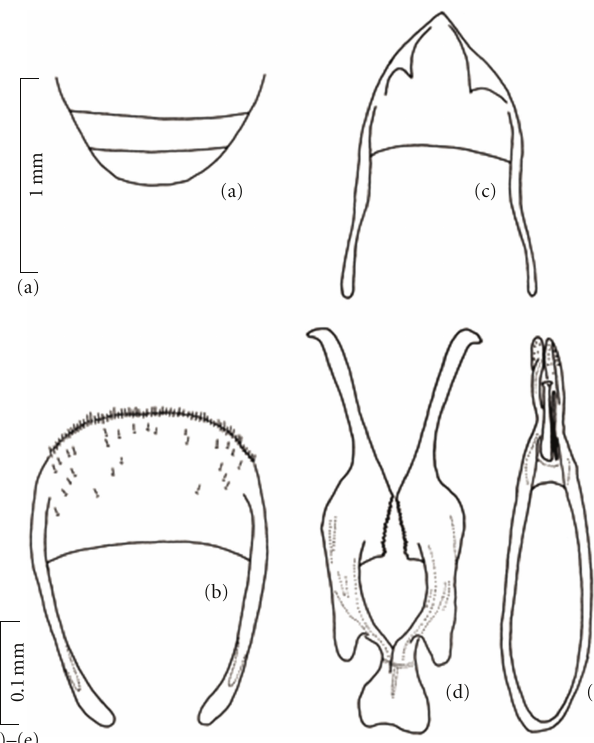
Figure 7: Hydrocyphon serratibasialis sp.n., holotype, male. (a) Sternites V–VII; (b) tergite VIII; (c) sternite IX; (d) tegmen; (e) penis.